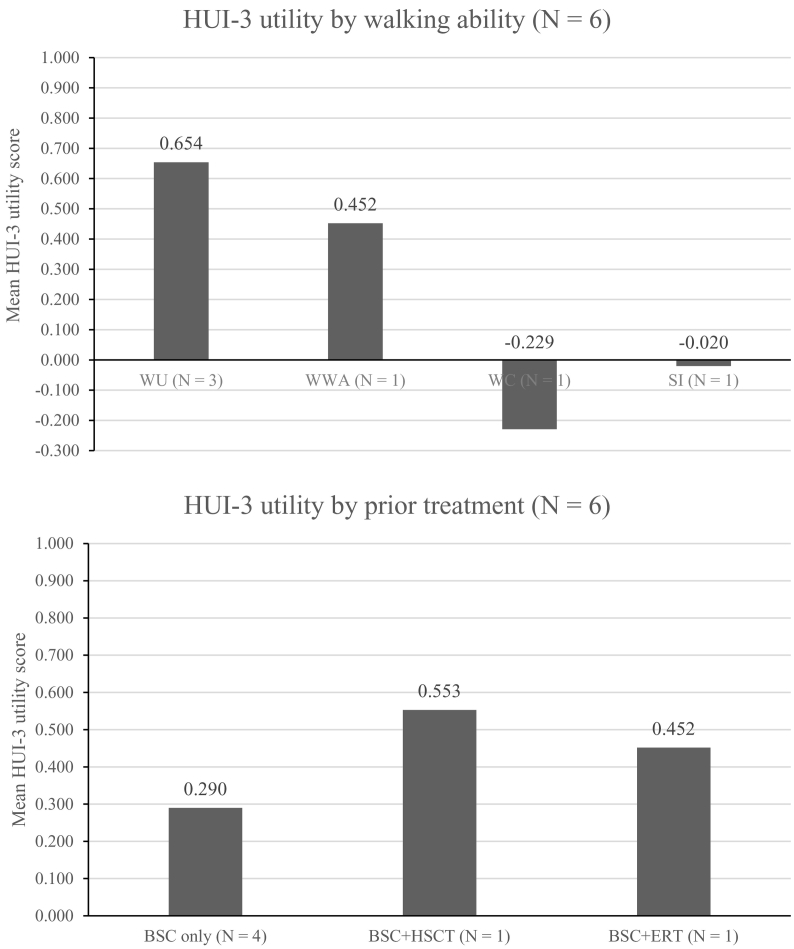
HRQoL of six patients as reported by proxy measured using the HUI-3 questionnaire by walking ability (top) and prior treatment (bottom). HUI-3 utility scores could be calculated for six patients; no data were available for the other three patients. Utility scores are calculated by applying a formula that attaches weights to each of the levels in each dimension. A utility score of 1 indicates ‘perfect health’, a value of 0 indicates ‘death’. Negative values indicate ‘feeling worse than death’.Abbreviations: BSC, best supportive care; ERT, enzyme replacement therapy; HUI-3, Health Utility Index–3; HRQoL, health-related quality of life; HSCT, haematopoietic stem cell transplantation; SI, severe immobility; WC, wheelchair-dependent; WU, walking unassisted; WWA, walking with assistance.